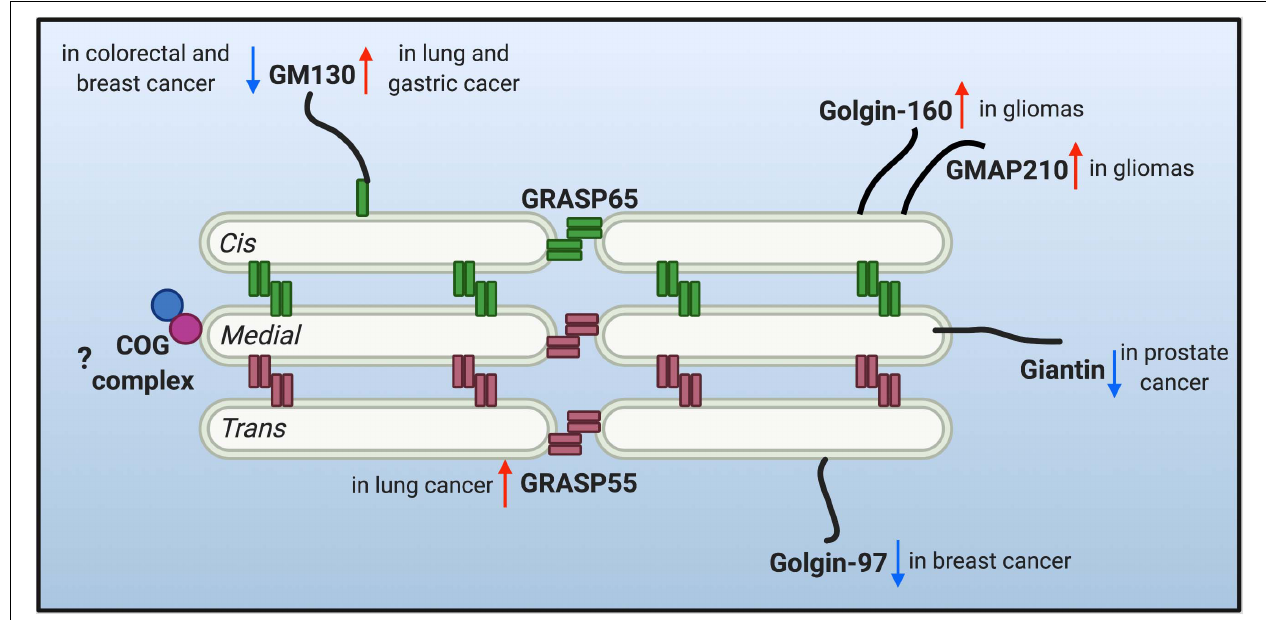
FIGURE 1 | Protein level alteration of the reported Golgi structural proteins in various cancer types. Golgi reassembly-stacking proteins (GRASPs) (GRASP65 and GRASP55) and golgin families of proteins contribute to the structural scaffold that defines the Golgi architecture, and are conceived as the Golgi matrix. Altered protein levels of the Golgi matrix are discovered in different cancer types and may facilitate tumor progression. Upward red arrows indicate upregulated protein level, while downward arrows indicate down-regulated protein level of different matrix proteins in different cancer cells. Few studies are correlating the tethering conserved oligomeric Golgi (COG) complex with tumor metastasis, so a question mark is shown.